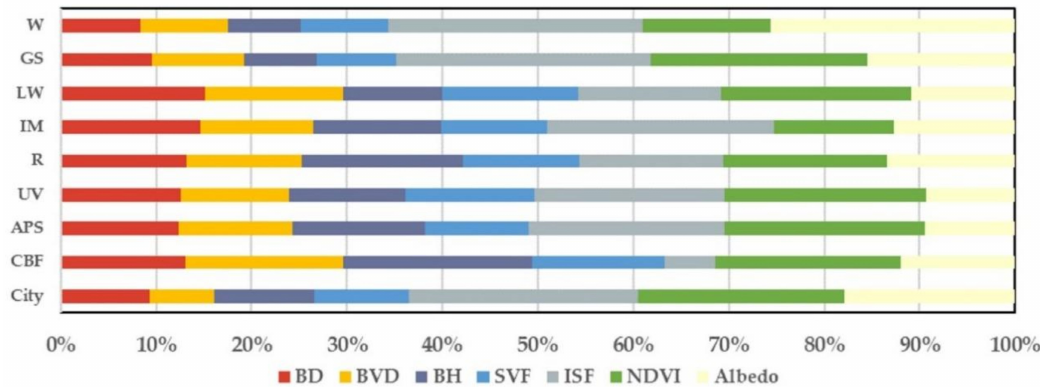
Figure 6. Comparison of the importance of landscape indicators regarding the LST in di ff erent UFZs by RF regression.